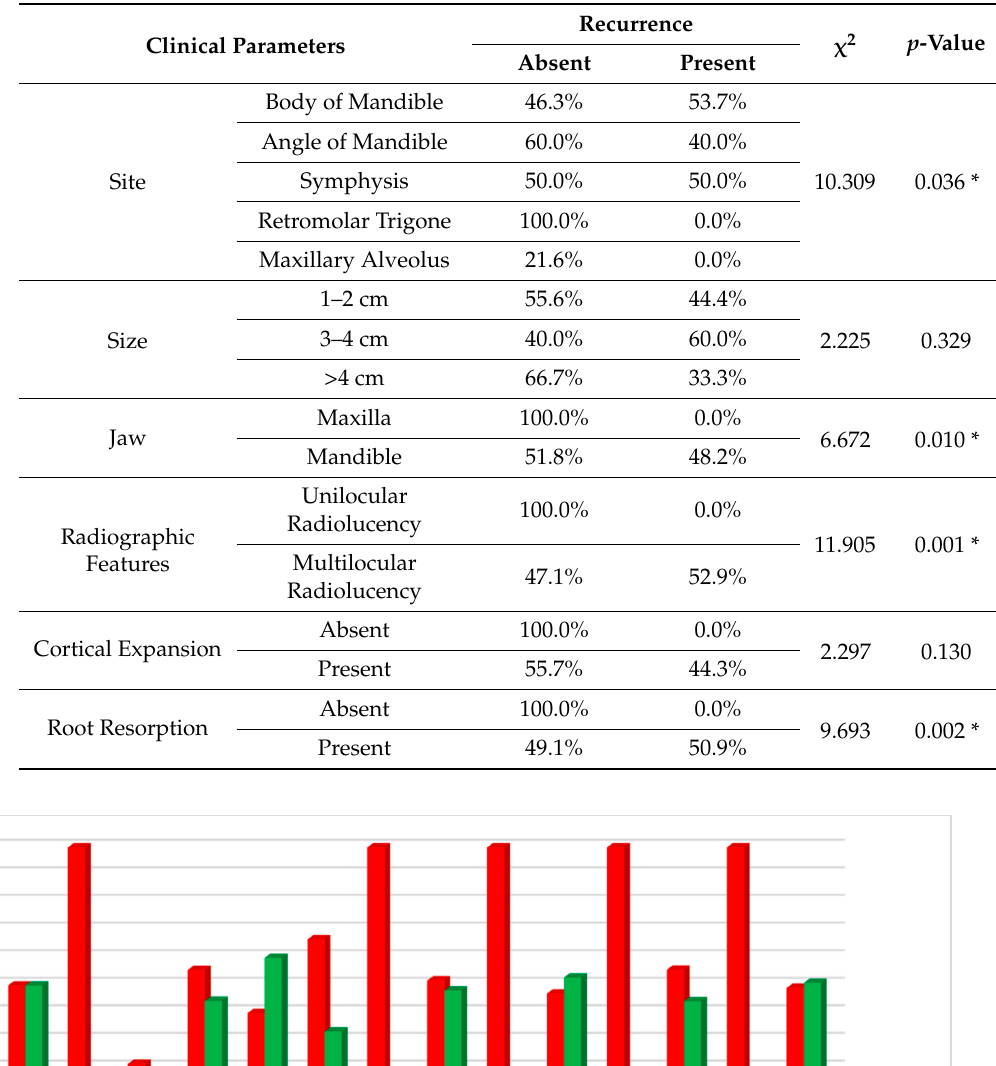
Table 3. Comparison of correlation of clinical parameters with recurrence of solid multicystic ameloblastoma. * Indicates significance.